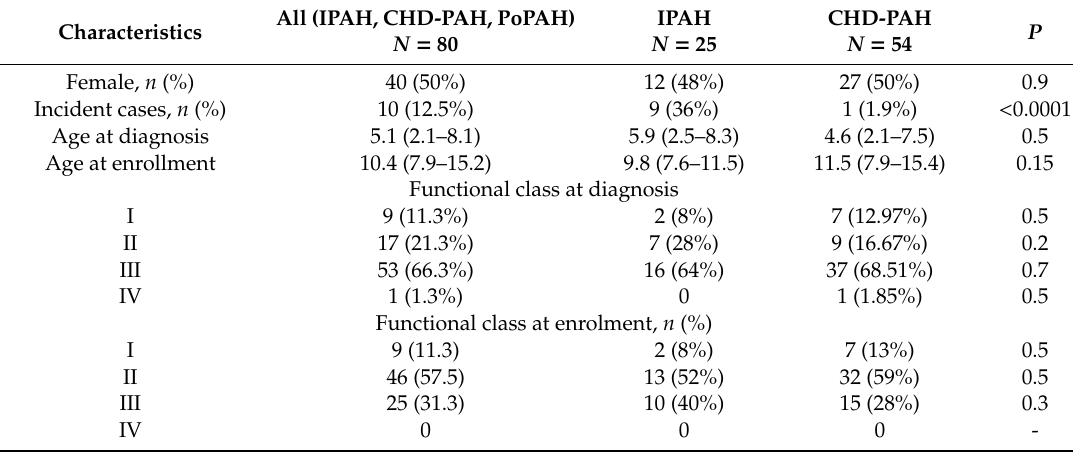
Table 3. Demographic and baseline characteristics of children with idiopathic pulmonary arterial hypertension (IPAH) and pulmonary arterial hypertension associated with congenital heart disease